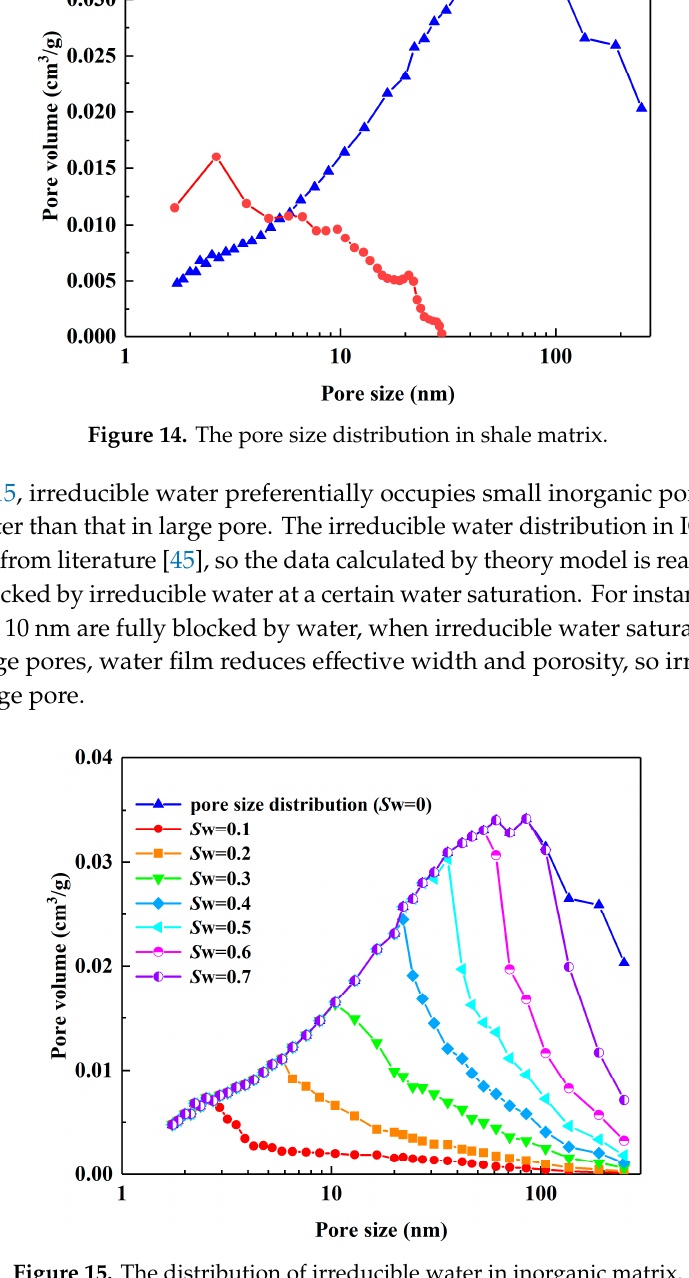
Figure 15. The distribution of irreducible water in inorganic matrix.